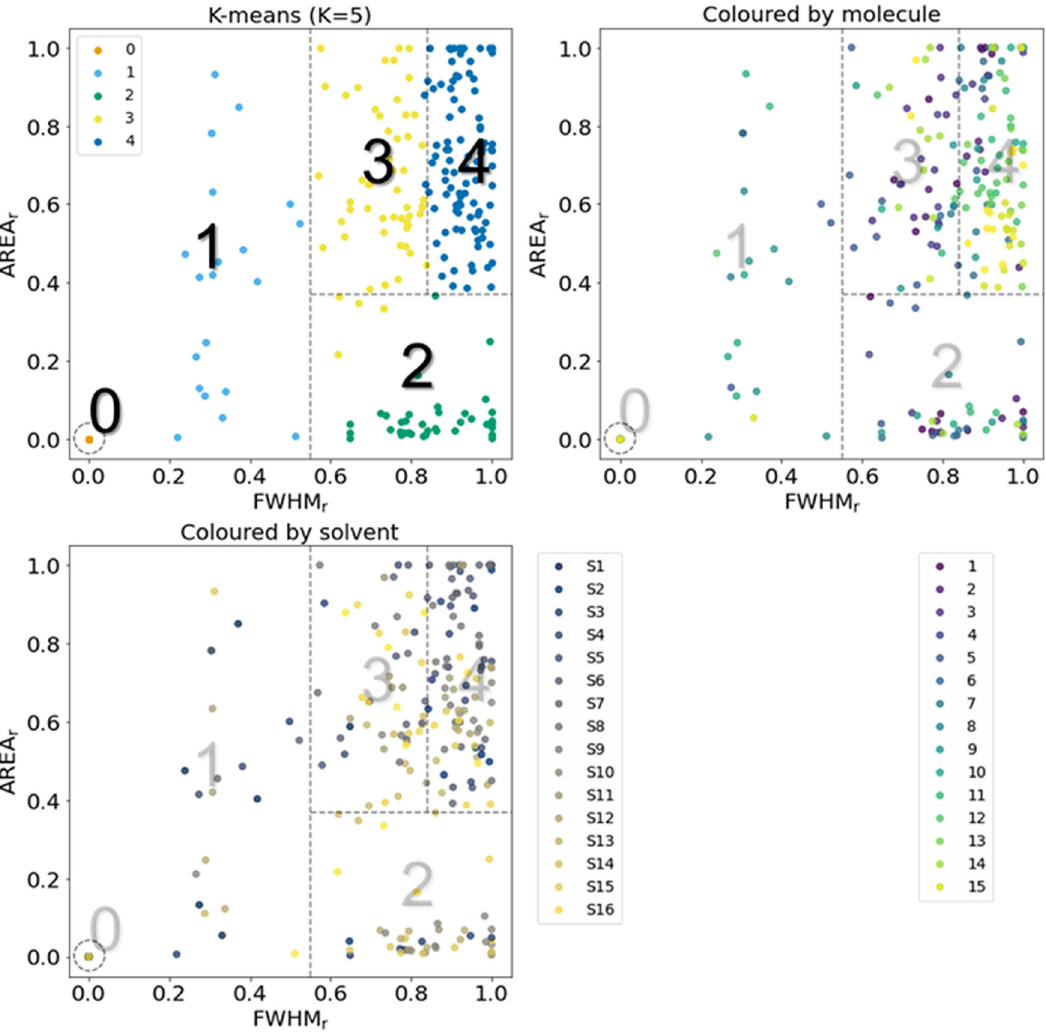
Fig. 6 Mapping all 240 evaluations over FWHM r and Area r . Colored points in top-left fi gure follow K-means ( K = 5) clustering and are simply categorized into fi ve categories (0 – 4) according to values for each axis based on clusters. Colored points in top-right and bottom fi gures depict types of molecules in MW order and solvents in epsilon order, respectively. Table 1 Results of two-class classi fi cation and regression. Two-class classi fi cation